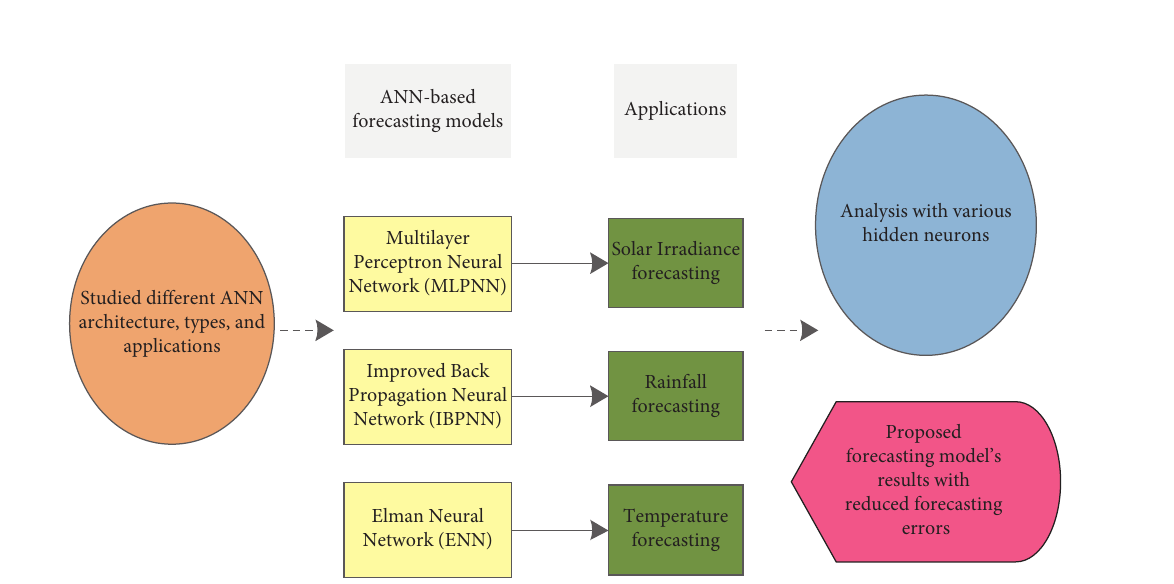
Figure 2: Proposed forecasting model road